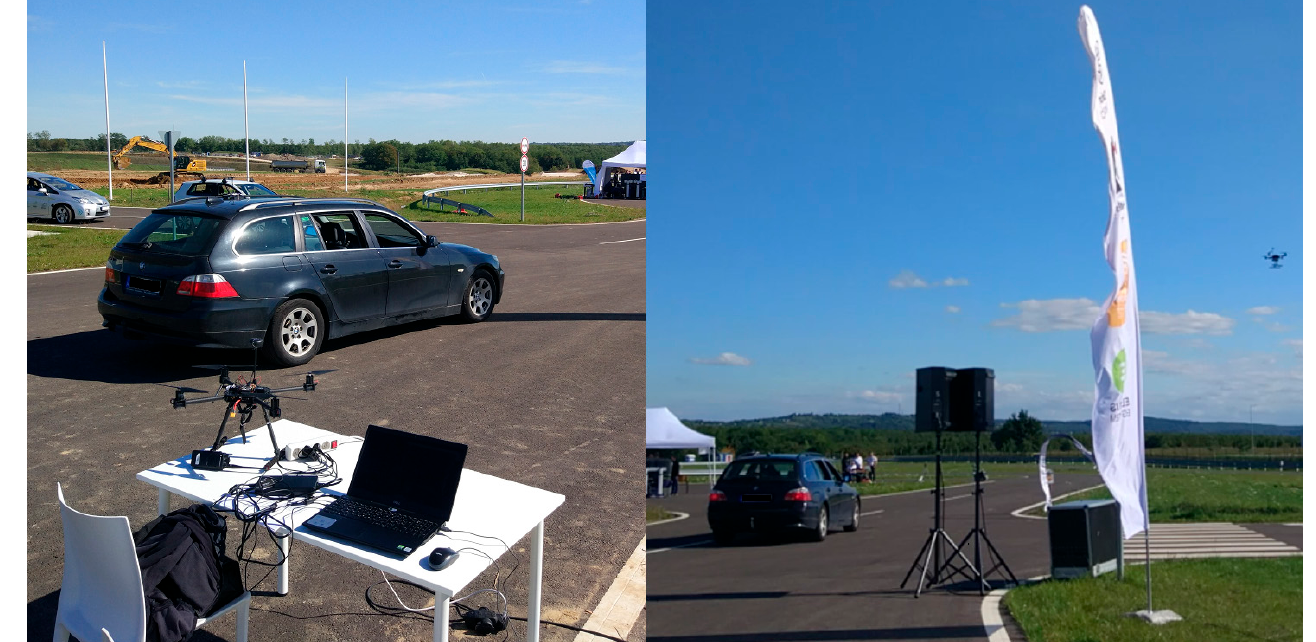
Figure 11. ZalaZone demo setup: ground control station and system users ( left ), system in operation ( right ).